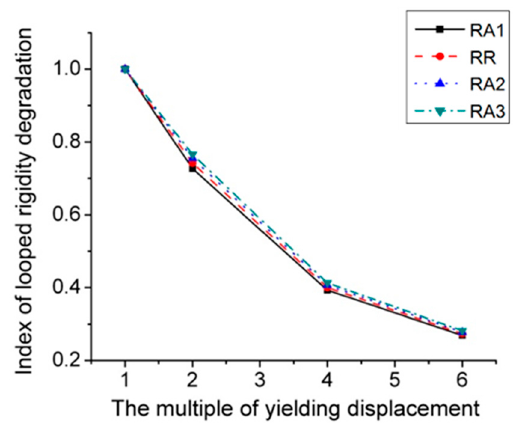
Figure 11. Index of looped rigidity degradation curves of RA series joints.